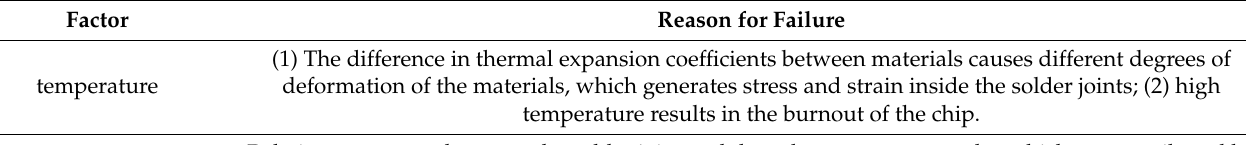
Table 1. Summary of failure factors and failure reasons for electronic components. Factor Reason for Failure